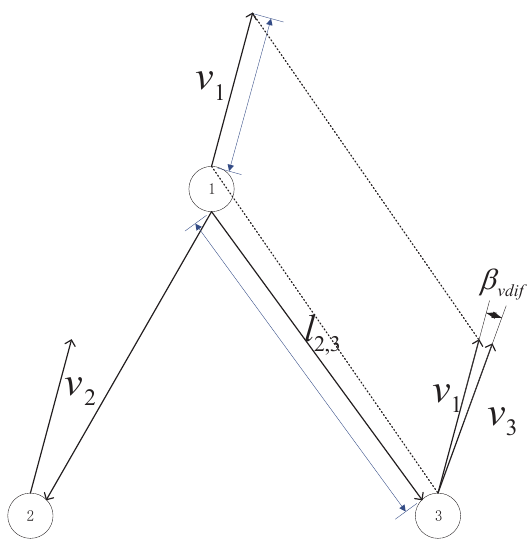
Figure 3. Schematic diagram of velocity in group target v , distance between father and son target l ij , and velocity deviation β vdif